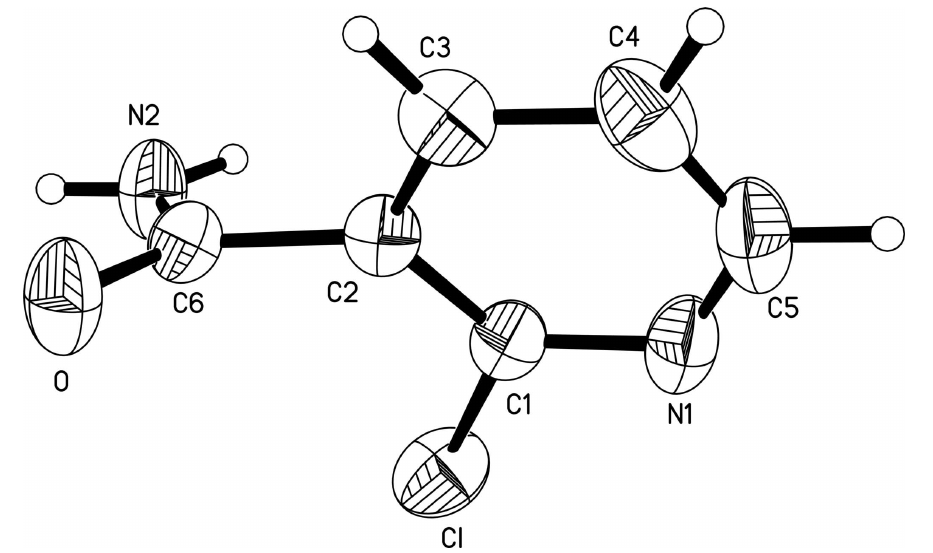
Figure 1 View of the molecule of the title compound showing the atom-labelling scheme. Displacement ellipsoids are drawn at the 50% probability